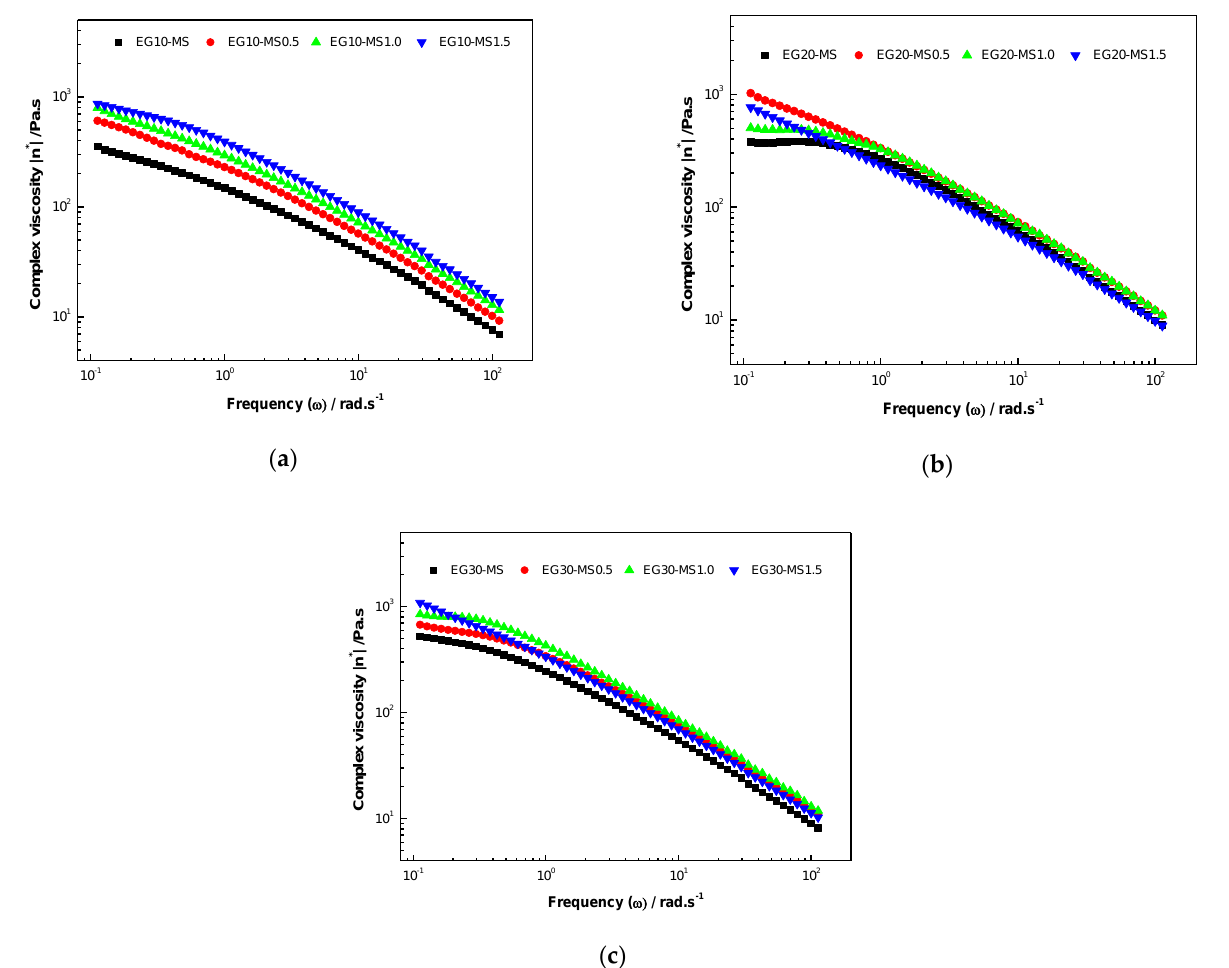
Figure 4. Complex viscosity as a function of frequency ( ω ) of carboxymethyl cellulose/mango-starch emulsion gels with 1% w/w of mango peel extracts at ( a ) 10%, ( b ) 20% and ( c ) 30% of canola